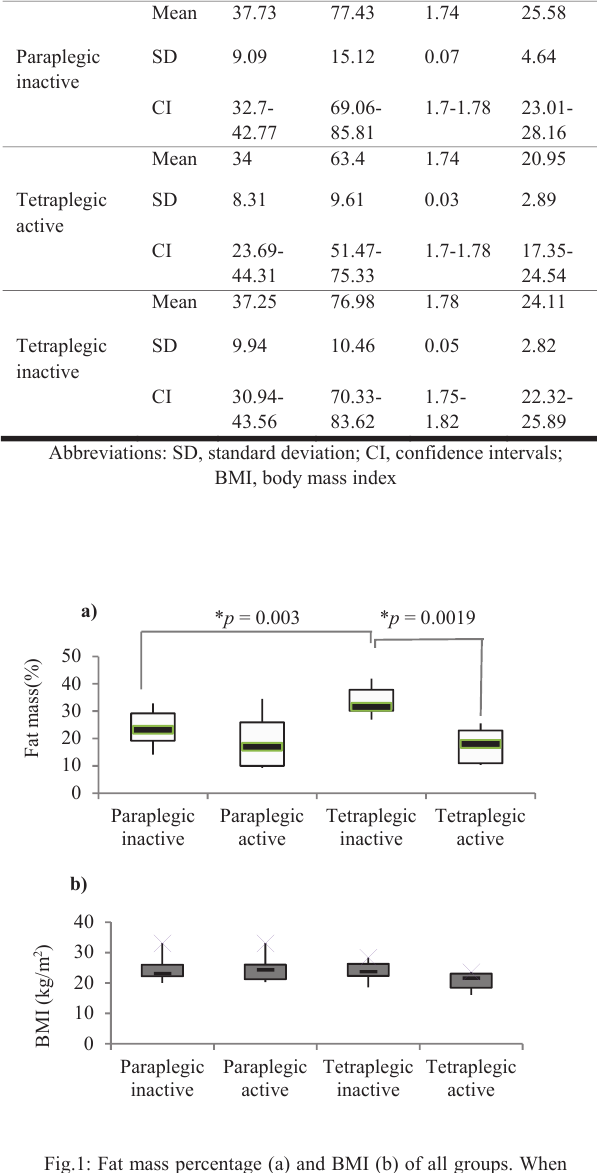
Fig.1: Fat mass percentage (a) and BMI (b) of all groups. When groups were compared differences can be observed in fat mass for paraplegic inactive group X tetraplegic inactive group ( p =